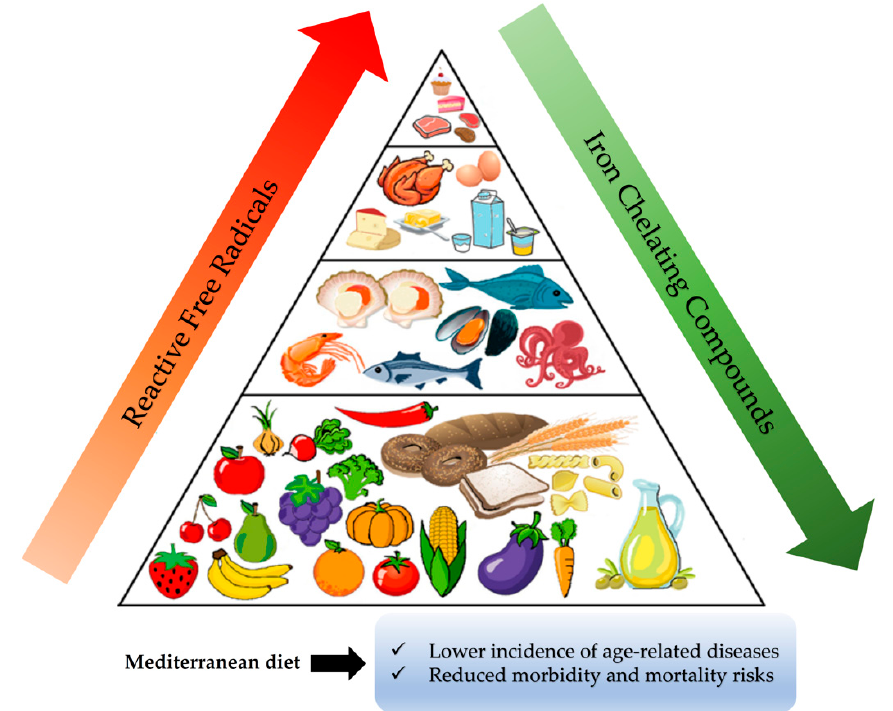
Figure 4. Schematic presentation indicating that the plant-derived foods of the Mediterranean diet contain increasing amounts of iron-binding compounds able to chelate intracellular labile iron and to prevent the generation of highly reactive free radicals that are responsible for the unregulated oxidation of cell